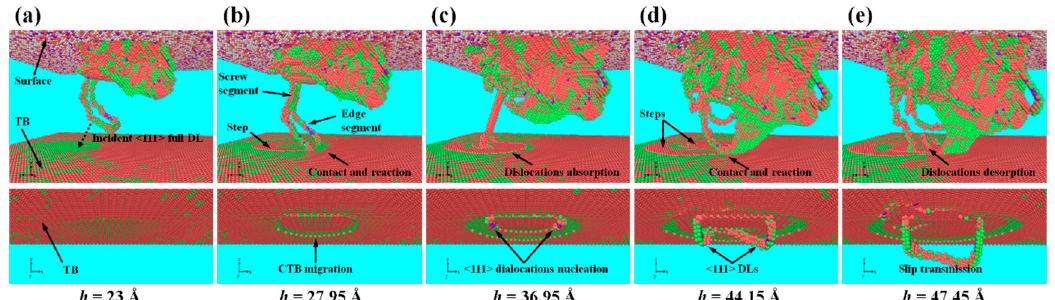
Figure 3. Microstructure evolution of the sample at different h , with atoms colored by polyhedral template matching (PTM). Upper row of figures show defects in the first layer, lower row of figures show defects in the second layer.